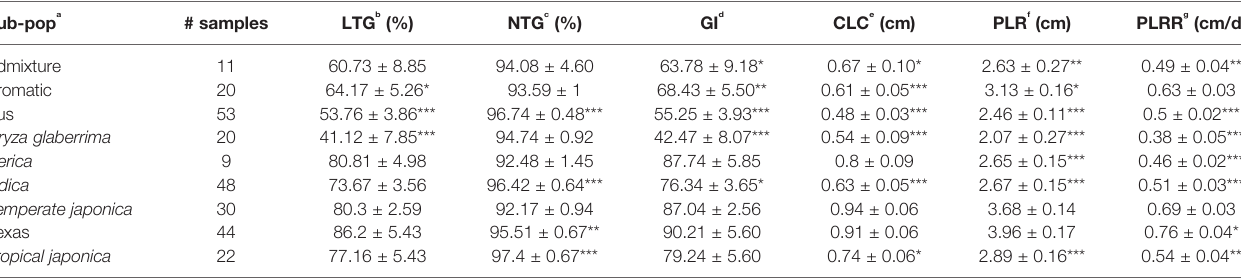
TABLE 2 | Phenotypic performance of nine sub-populations generated within the whole diversity panel. Sub-pop a #